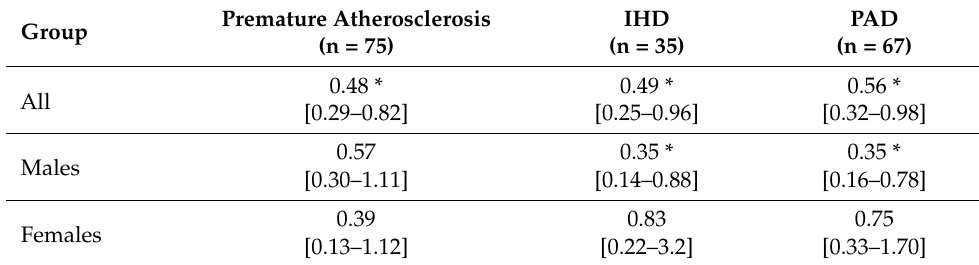
Table 4. Risk of atherosclerotic disease according to UGT1A1 [TA] 7